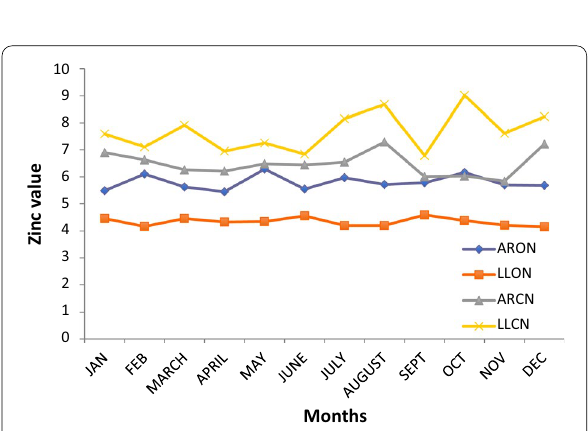
Fig. 5 Mean Comparative Zinc (Zn) concentration among C. nigrodigitatus and O. niloticus species collected from Asejire Reservoir and Lagos